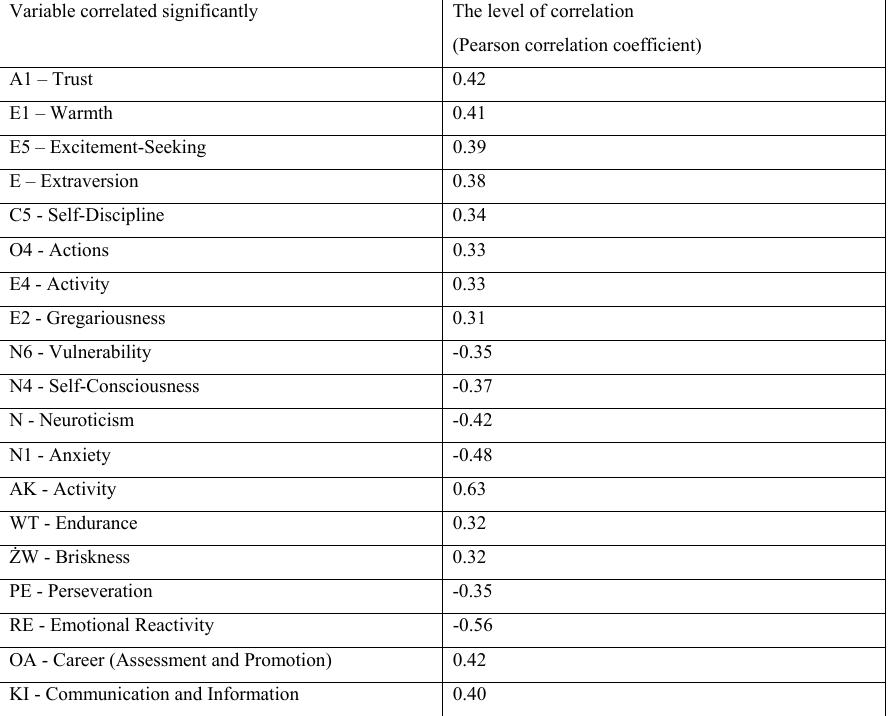
Table 1. presented significant correlations at p <0.05 in the group of volunteers: Table 1. Correlations (Pearson's coefficient) significant at the level of significance equal to p